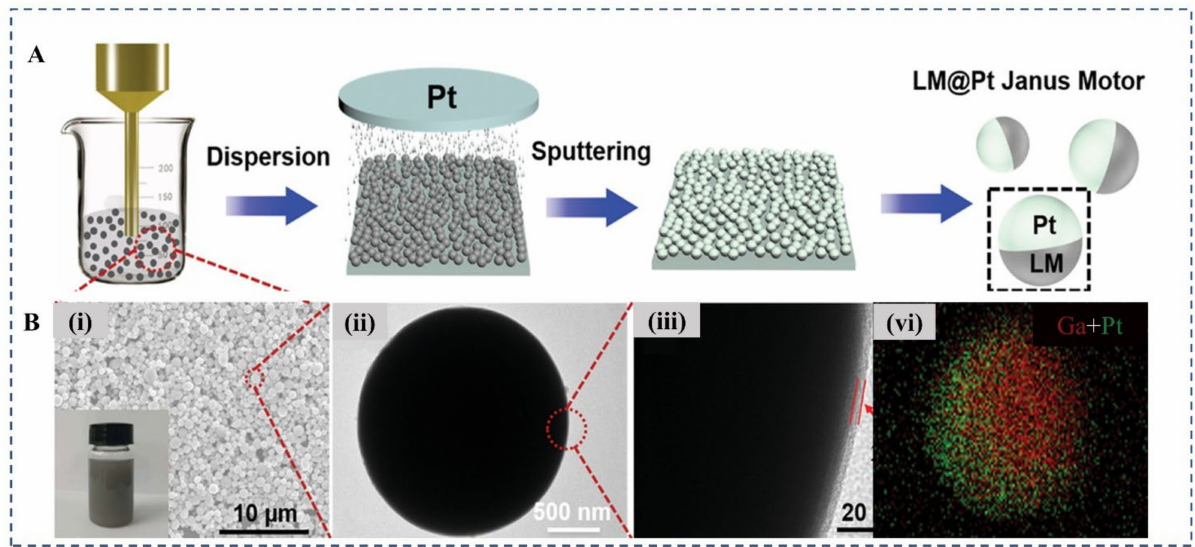
Figure 9. Two-steps fabrication methods for MLMTs. ( A ) Fabrication of the LM-Pt Janus particles via sputtering Pt onto LMNPs produced by ultrasonication [6]. ( B ) ( i ) SEM image of the LM spheres fabricated by ultrasonic dispersion. ( ii ) The symmetric LM sphere fabricated by ultrasonication is shown by the TEM image. ( iii ) A thin Ga 2 O 3 shell on the LM sphere. ( vi ) The LM-Pt the distribution of the asymmetric elements after spurting is shown by EDS elemental mapping. [6].